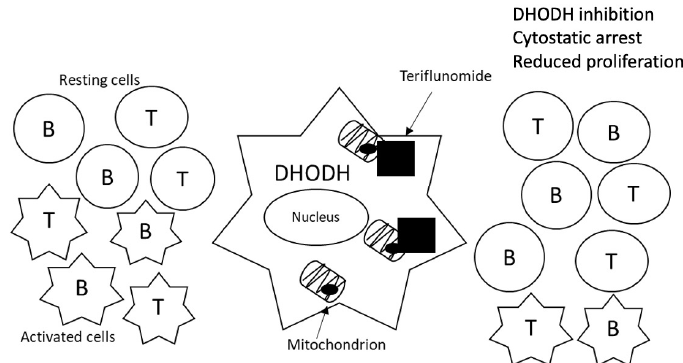
Figure 2. Mechanism of action of teriflunomide.